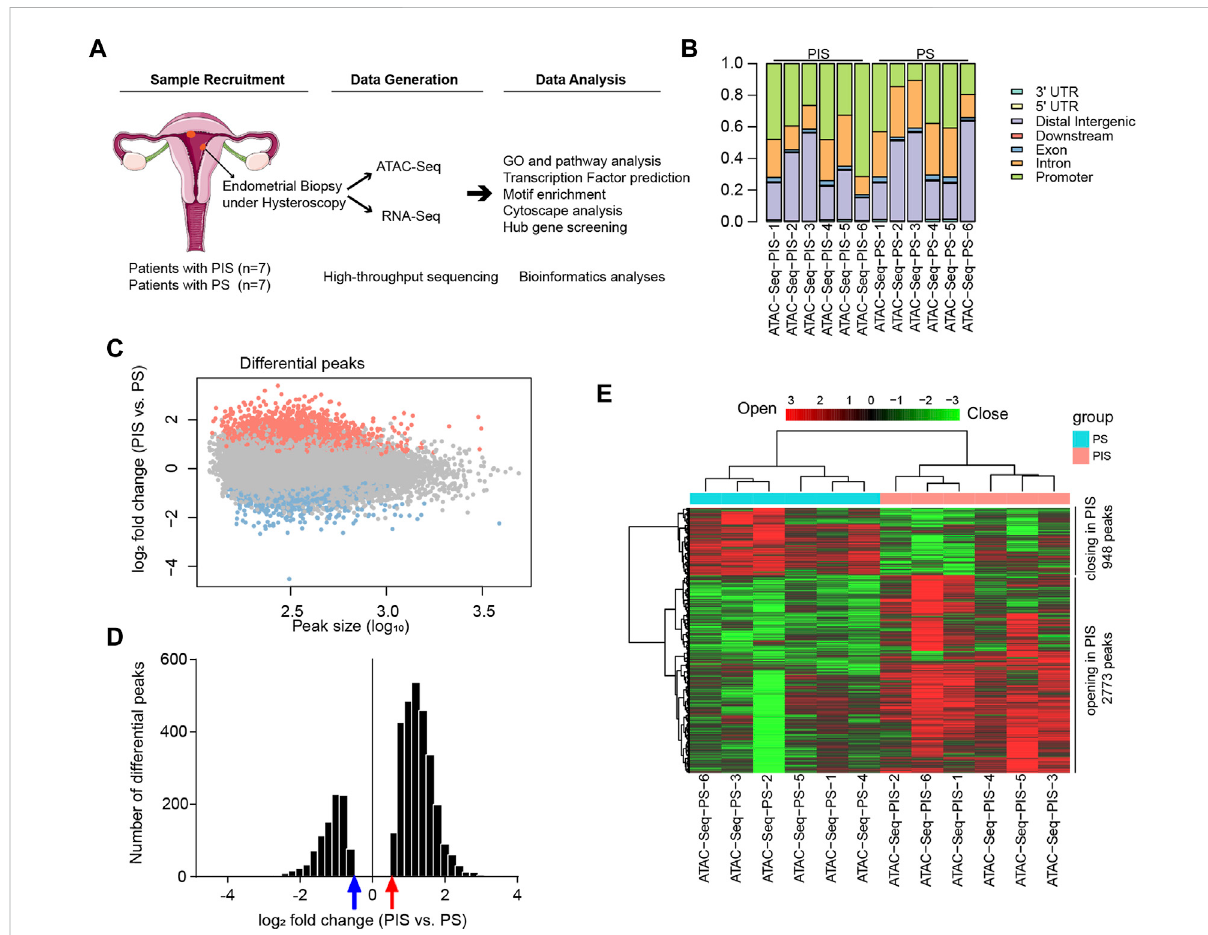
FIGURE 1 Landscape of genomic chromatin accessibility by ATAC-Seq. (A) Flowchart of study design. Endometrial lesions in the Analysis Group were collected for ATAC-Seq and RNA-Seq and further data analysis. (B) Genomic distribution of differential peaks. Bars with different colors and lengths represent different elements in the human genome and proportions, respectively. (C) Scatter plot of the chromatin accessibility at each peak in the PIS group compared to the PS group. The X-axis represents the peak size (log 10 ), and the Y-axis represents the log 2 fold change (PIS vs. PS) in ATAC-Seqanalysis.The orange-reddotsrepresent theopeningpeaksandthelight bluedotsrepresenttheclosing peaksinthePIS group compared tothePS group. (D) Thehistogram presentsthedistributionoflog 2 foldchangeofthedifferential peaks(PISvs.PS).Theabscissa representslog 2 fold change of the differential peaks (PIS vs. PS) and the vertical axis represents the number of the differential peaks. Red arrow indicates log 2 fold change = 0.5849 while blue arrow indicates log 2 fold change = − 0.5849. (E) Hierarchical cluster analysis of all the regulated opening and closing peaks in genes. Red platesrepresent opening peaks, while green plates indicate closing peaks in the PIS and PS groups. Abbreviations: PIS, progestin insensitive; PS, progestin sensitive; ATAC-Seq, assay for transposase-accessible chromatin sequencing; RNA-Seq, RNA sequencing; UTR, untranslated